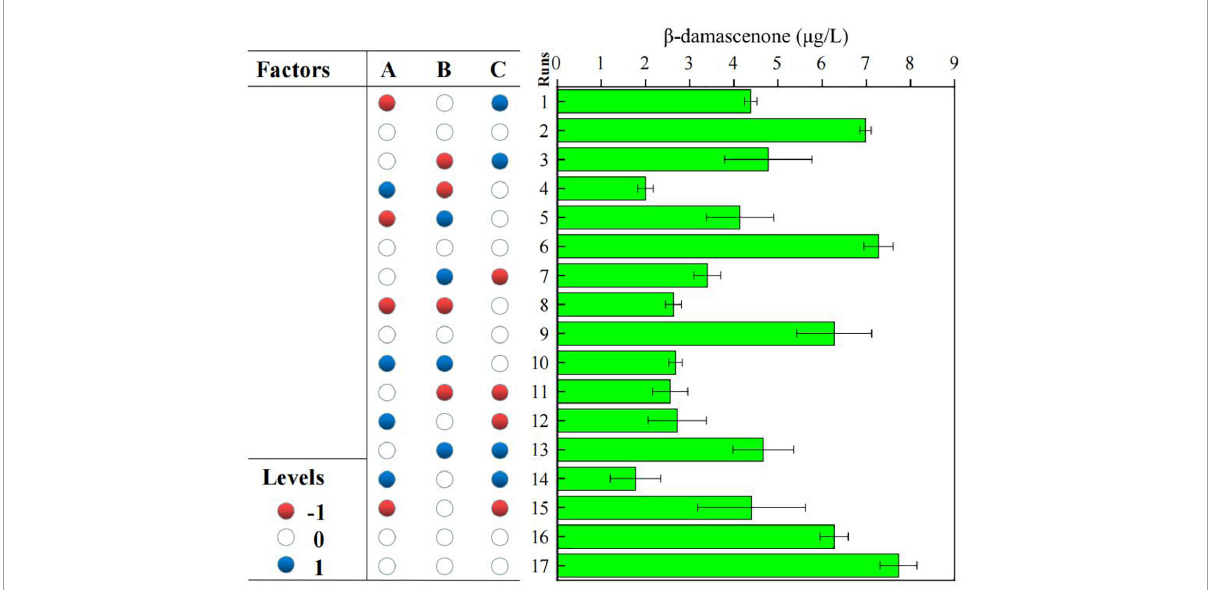
FIGURE4 Experimental design based Box-Behnken design (BBD) model of response surface methodology (RSM) for the optimization of β -damascenone production.